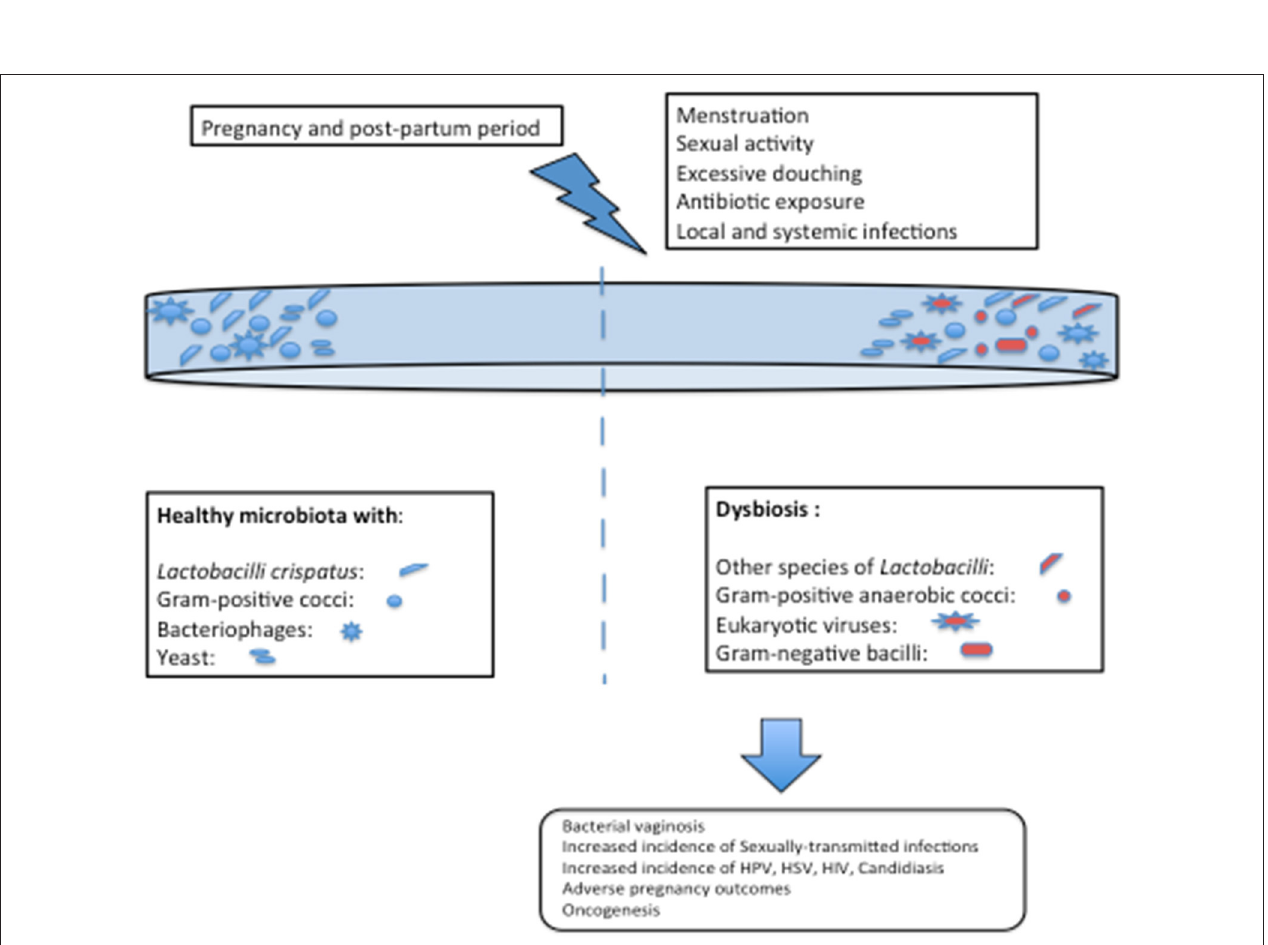
FIGURE 2 | Risk factors for alteration in vaginal microbiome and consequences of dysbiosis.